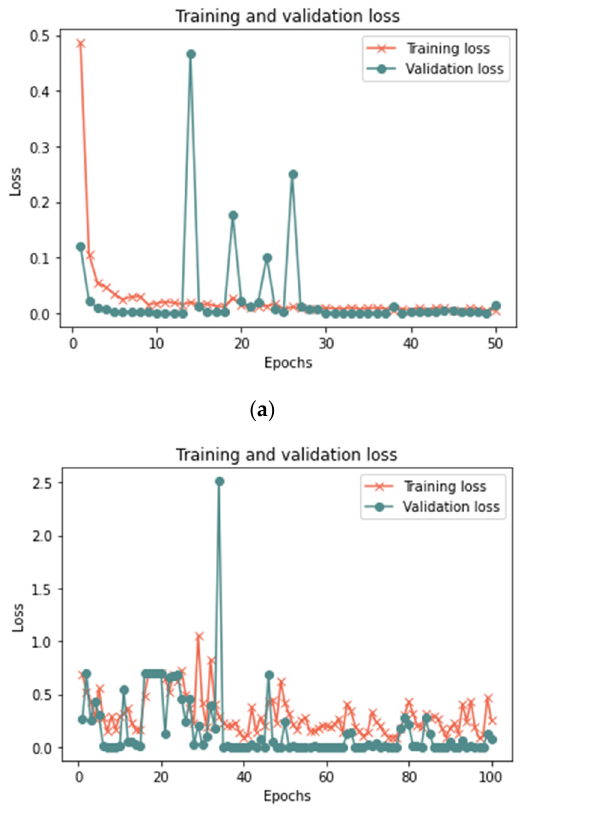
Figure 11. Results of the fi rst scenario with 50% sample size: ( a ) loss at 50 iterations; ( b ) accuracy at 50 iterations; ( c ) loss at 100 iterations; and ( d ) accuracy at 100 iterations.